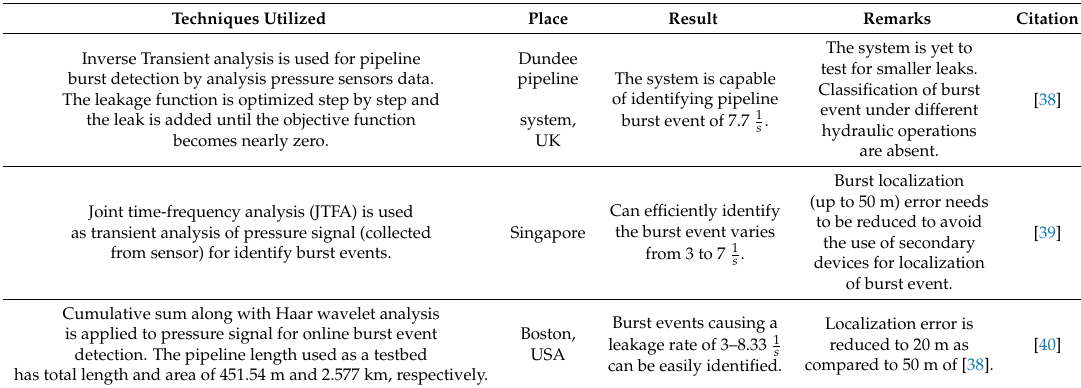
Table 2. Smart water techniques for burst event detection in